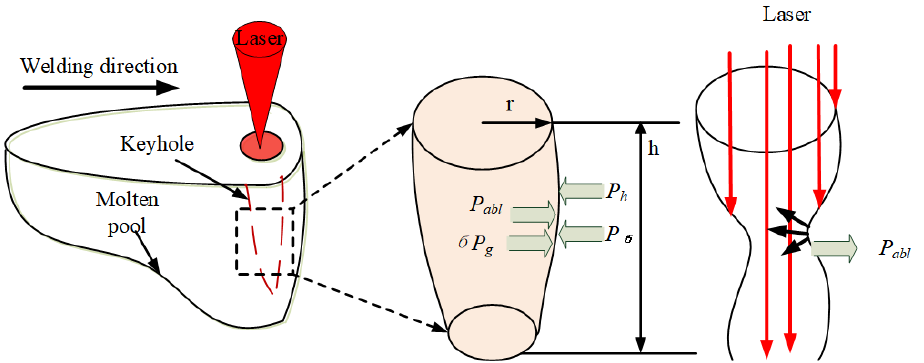
Figure 13. Relationship between the deformation of the keyhole wall and the acting force.